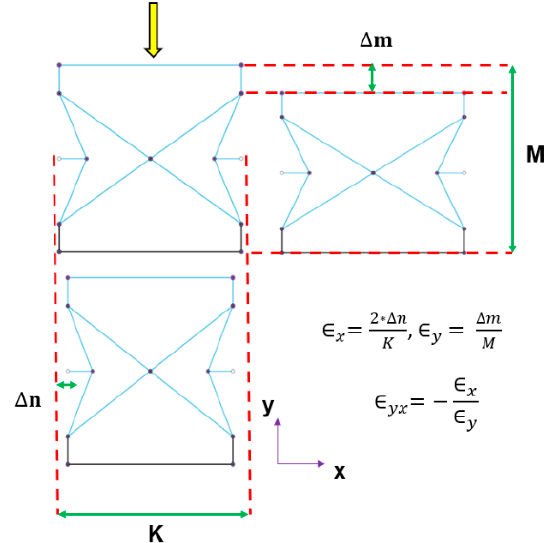
Figure 3. Effective Poisson’s ratio (EPR) determination for the MFAU cell.